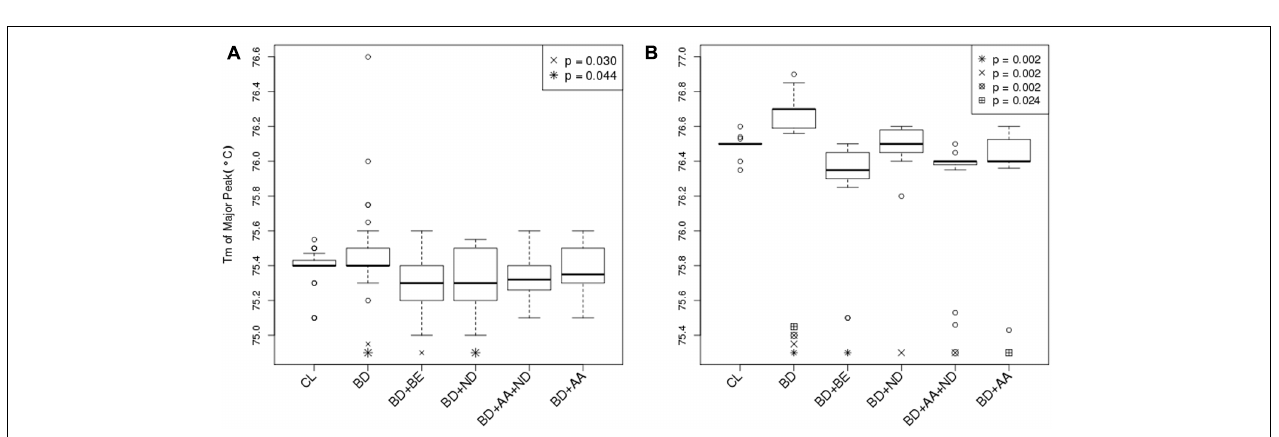
FIGURE 2 | DNA methylation is measured by high resolution melting (HRM) method. (A) Normalized melting curves of amplicon 1 between –1759 and –1468. The standards melting curves include 0, 25, 50, 75, and 100% methylated human control DNAs. (B) Normalized melting curves of amplicon 2 between –785 and –654. The standards melting curves include 0, 25, 50, 75, and 100% methylated human control DNAs.